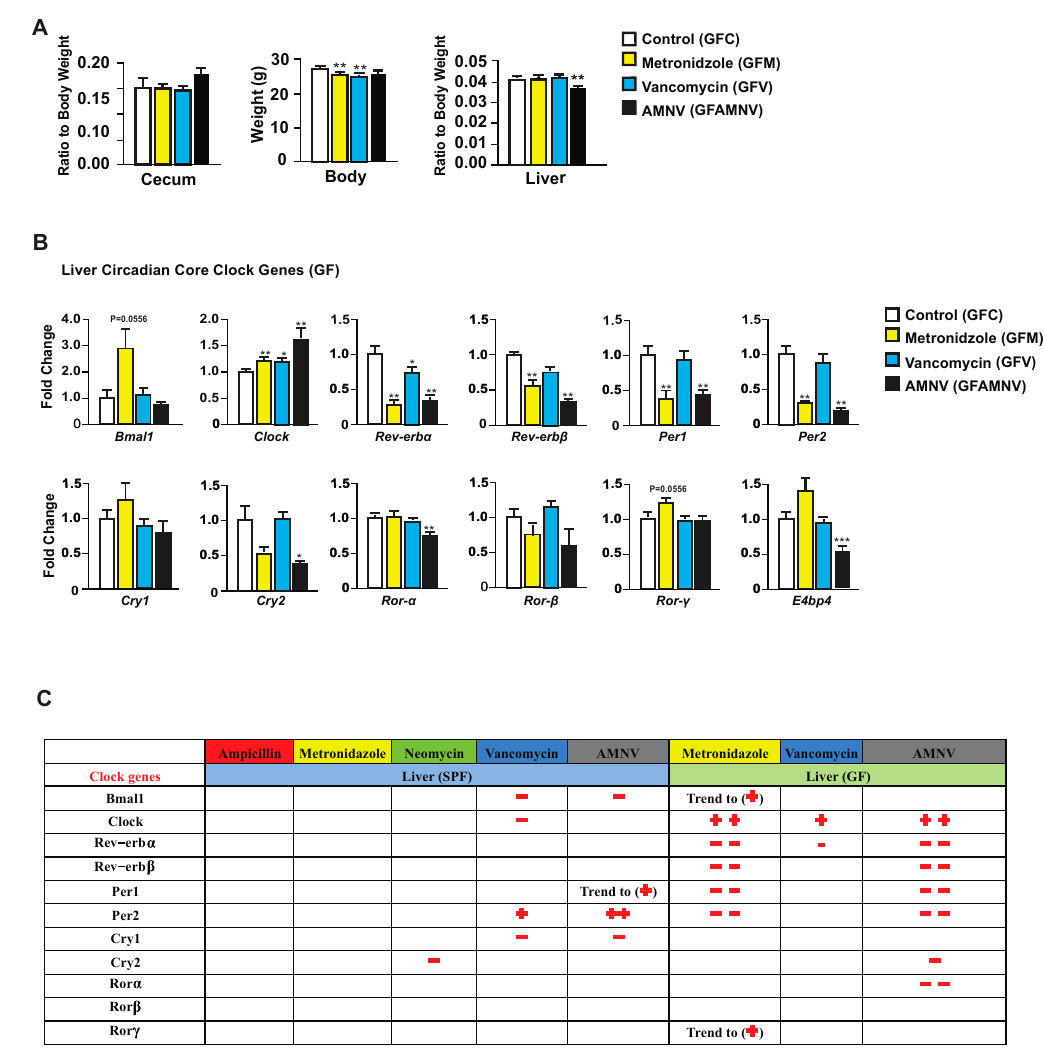
Figure 3. Phenotype and liver core clock gene expression of antibiotic-treated germfree (GF) mice. ( A ) Average cecum to body weight ratio, body weight and liver to body weight ratio of GF animals after four weeks of the respective antibiotic treatments ( n = 10, except for cecum measurement in the GF vancomycin and antibiotic combination (GF AMNV) treatment group with n = 9). ( B ) Hepatic gene expression analysis in GF mice. Expression of selected genes with the color indication for each treatment group (see the color code on the right of the panel). Statistical analysis was done using the Mann-Whitney test ( n = 5). Data are presented as means ± standard error of the mean. Significance relative to control is represented by * for p -value < 0.05, ** for p -value < 0.01, *** for p -value < 0.001. ( C ) A summary comparing changes in liver clock gene expression after antibiotic treatment in SPF and GF mice (see Figure 5). Downregulation is represented by the − sign in red while upregulation is represented by + in red and the number of symbol indicates the level of statistical significance, with one symbol indicating a p -value < 0.05, two symbols indicating a p -value < 0.01, and three symbols a p -value < 0.001. Close to statistical significance data are shown as Trend to ( − ) or (+).